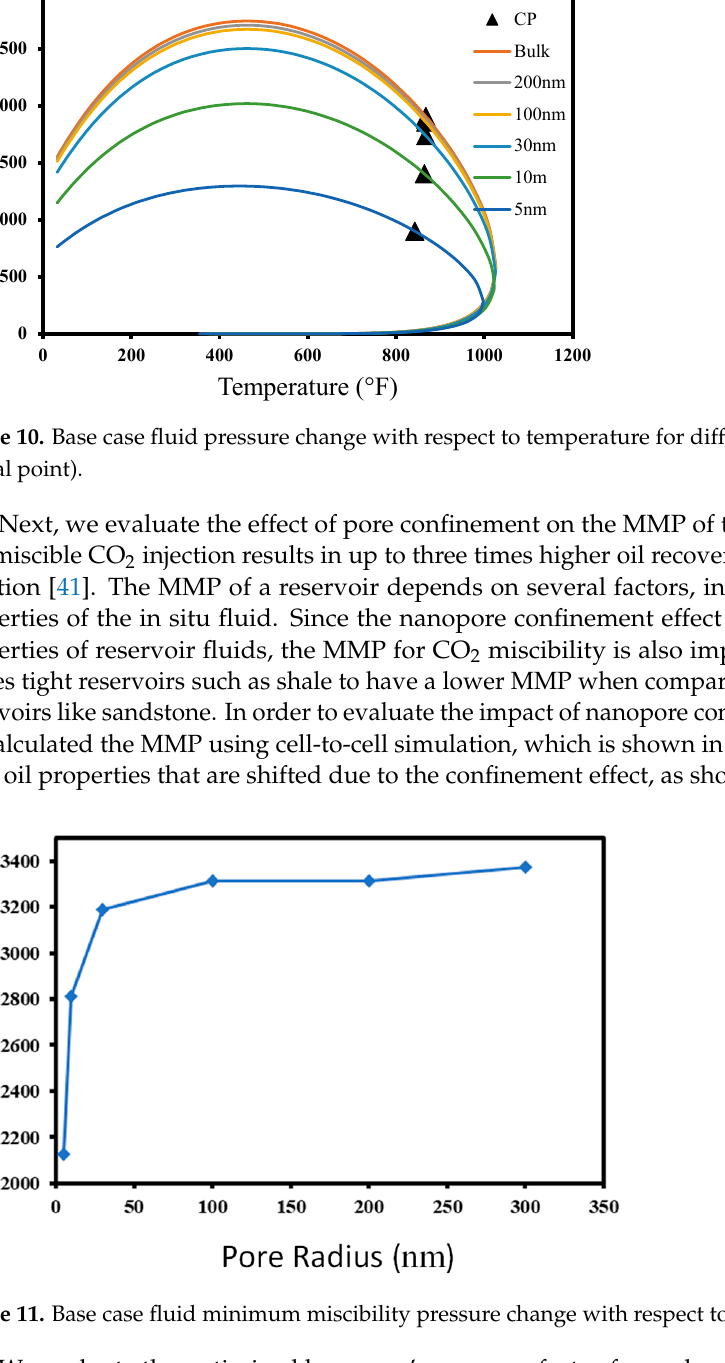
Figure 11. Base case fluid minimum miscibility pressure change with respect to pore radius.